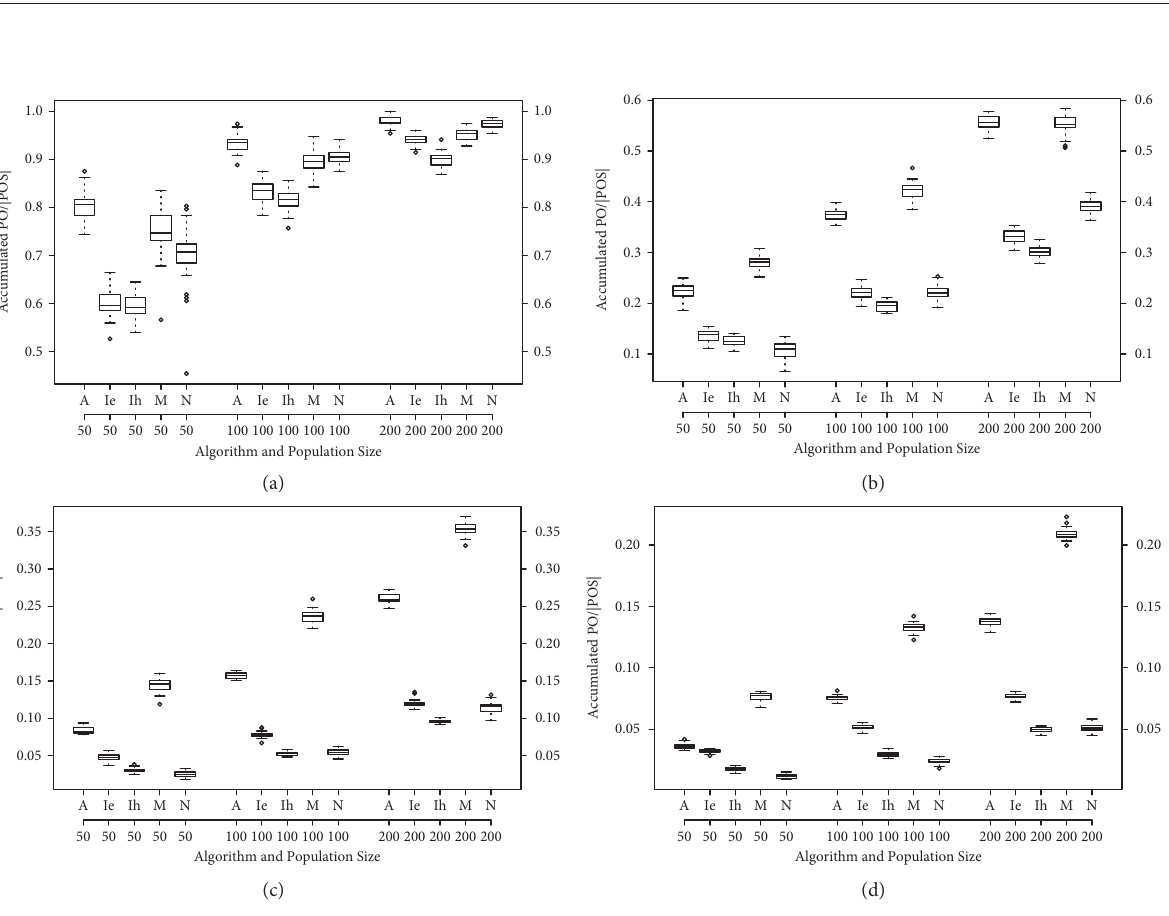
( I ) , IBEA ( I ) , h ε + ε HV